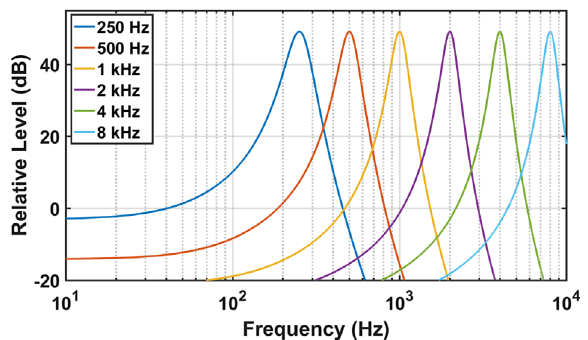
Figure 5. 10 s of a tone-pip EAE corresponding to the HL curves of Figure